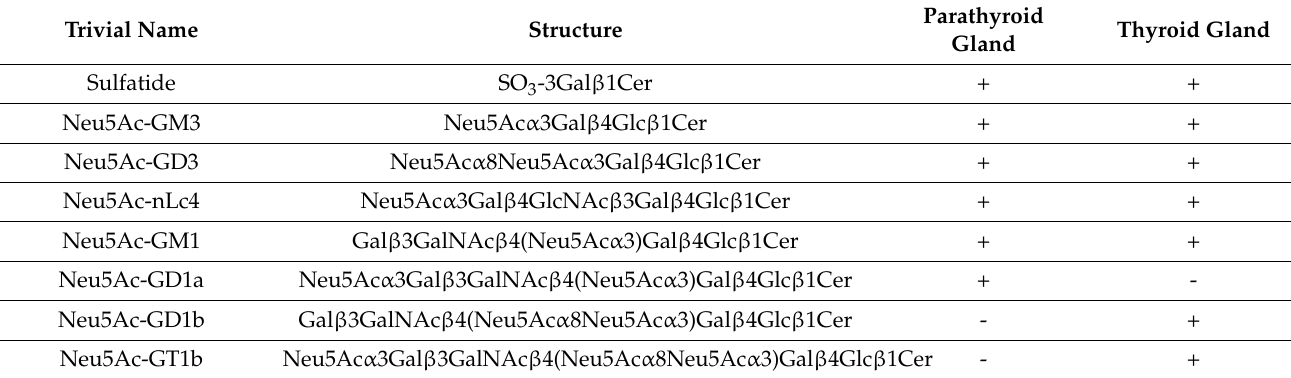
Table 3. Glycosphingolipids in the total acid fractions identified by